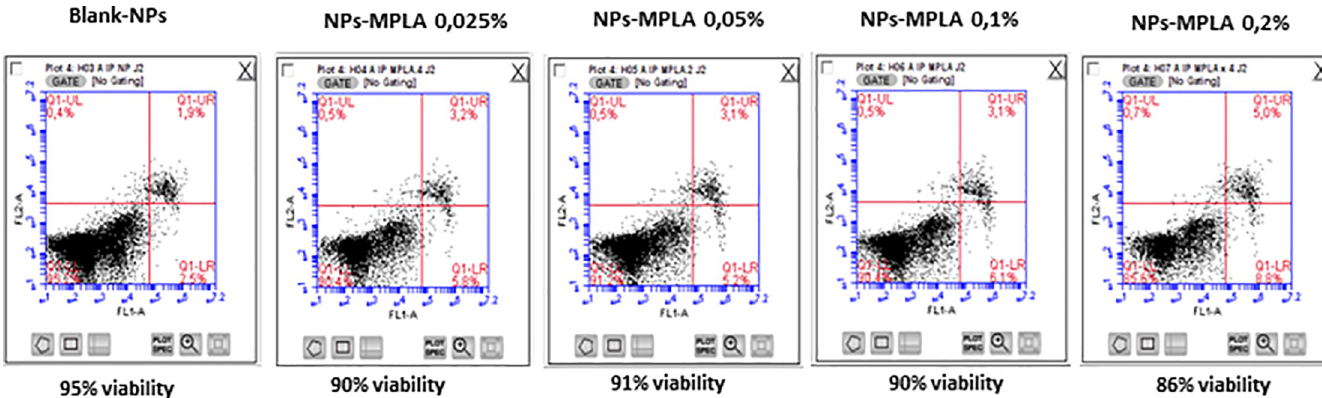
Fig 3. Flow cytometry profiles of cell viability obtained after Annexin V and IP staining of cMoDCs 48 h after incubation with Blank-NPs, NPs-MPLA 0.025%, NPs-MPLA 0.05%, NPs-MPLA 0.1% and NPs-MPLA 0.2%. Annexin V is on FL1-A channel and propidium iodide is on FL2-A channel.